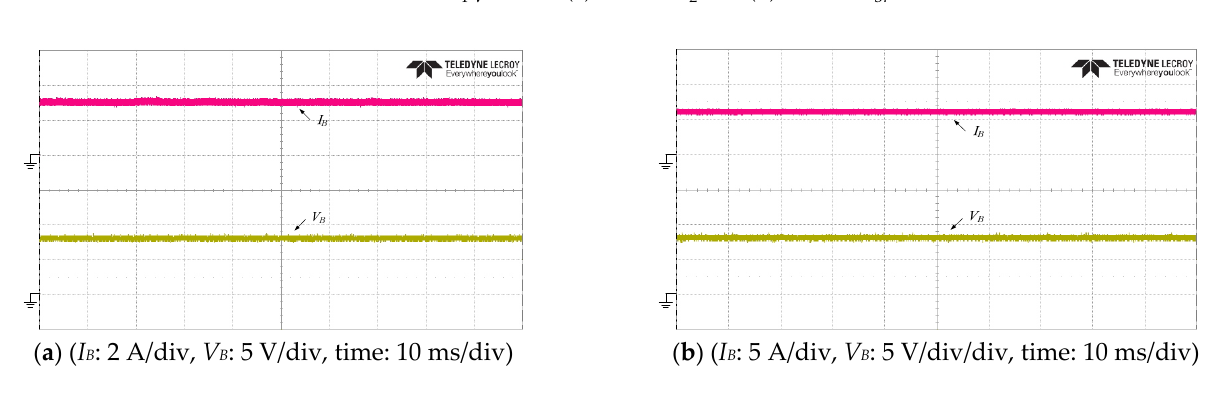
Table 6. Key components of the proposed hybrid converter.